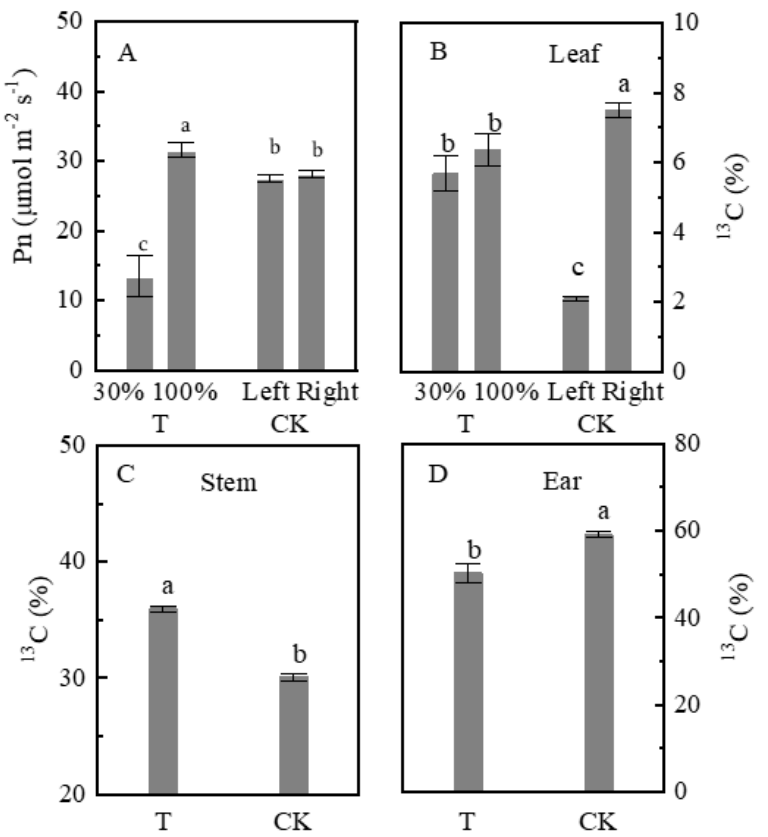
Figure 2. Net photosynthetic rate (Pn) in leaves and 13 C abundance of the organ in shading treatments. Figure 2 ( A ): leaf Pn; ( B ): 13 C abundance of leaf; ( C ): 13 C abundance of stem; ( D ): 13 C abundance of ear. Ear leaves were labeled with 13 CO 2 in the T-100% and CK-right groups. Plants grown under heterogeneous light (T), the left side leaves were under shade (T-30%) and right side leaf under natural light (T-100%). All leaves were under full sunlight (CK). Data are averages of three replicates and bars represent standard errors. Data with di ff erent letters are significantly di ff erent ( p <